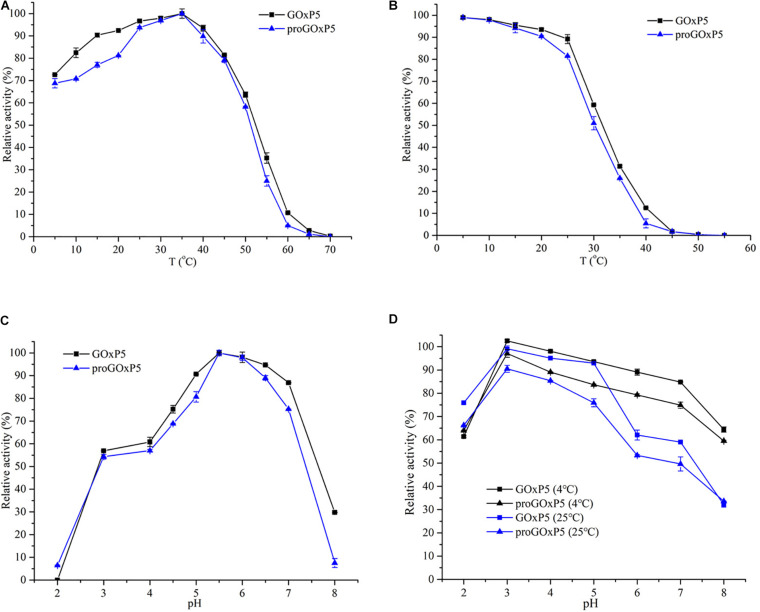
 Determination of optimum temperature (A), thermostability (B), optimum pH (C), and pH stability (D) of purified GOxP5 and proGOxP5. The optimal temperature was determined at temperatures ranging from 4 to 70°C in 50 mM sodium phosphate sodium citrate buffer (pH 6.0) (A). For the analysis of thermostability, the purified enzymes were incubated in 50 mM sodium phosphate (pH6.0) for 5 min at 40–60°C (B). The initial enzyme (without incubation) activity of each enzyme was defined as 100%. All the experiments were done in triplicates and the error bars indicate standard deviations. Optimal pH was measured in different buffers such as pH 2.0–3.0 (0.05 M glycine-HCl), pH 4.0–6.0 (0.05 M NaAc-HAc), and pH 7.0–8.0 (0.05 M Tris-HCl) (C). For pH stability analysis, the enzymes were incubated with the above buffers for 120 min at 4 and 25°C (D).